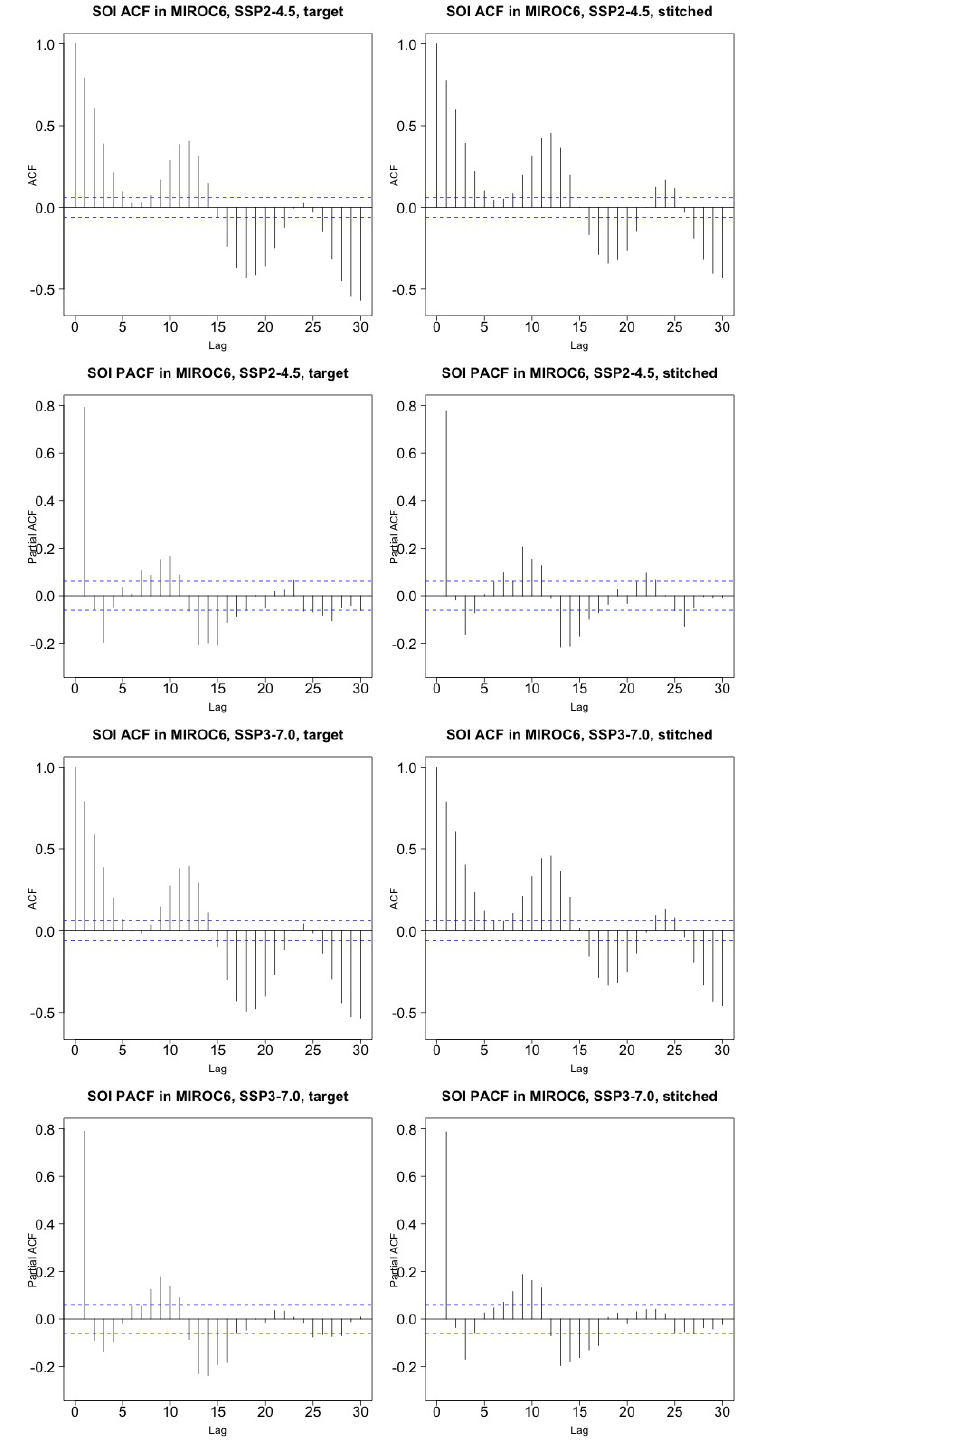
Figure D6. Auto-correlation functions (ACFs) and partial auto-correlation functions (PACFs) for real and stitched SOI time series. Top two rows: SSP2-4.5 ACF for target and stitched series and respective PACFs. Bottom two rows: SSP3-7.0 ACF for target and stitched series and respective PACFs. Results from emulation of one of three ensemble members emulated under each scenario for MIROC6. (Our software – R function acf(..,type="partial") – does not define the PACF at lag zero.)